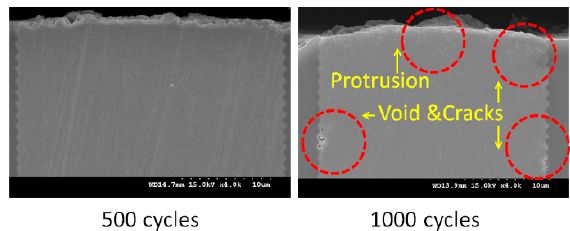
Figure 6. Thermal shock test (500 and 1000 cycles) of Cu filled TSV.